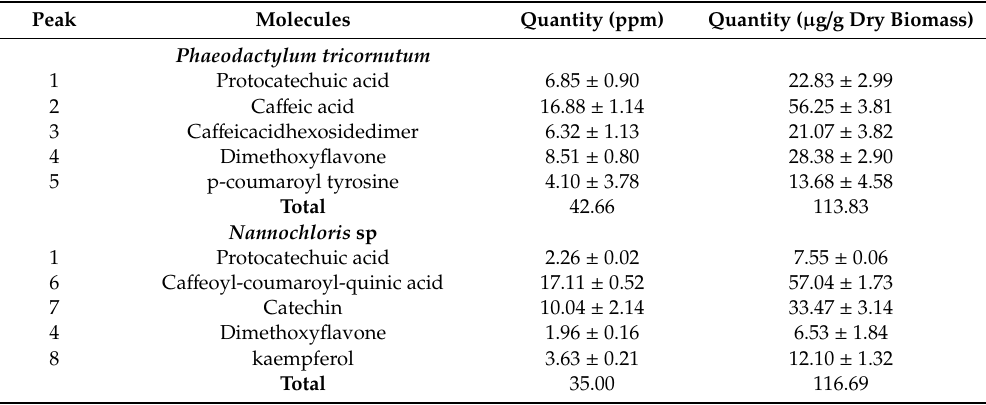
Table 4. Polyphenolic components, representative of the major classes, detected in the microalgae species, along with quantitative